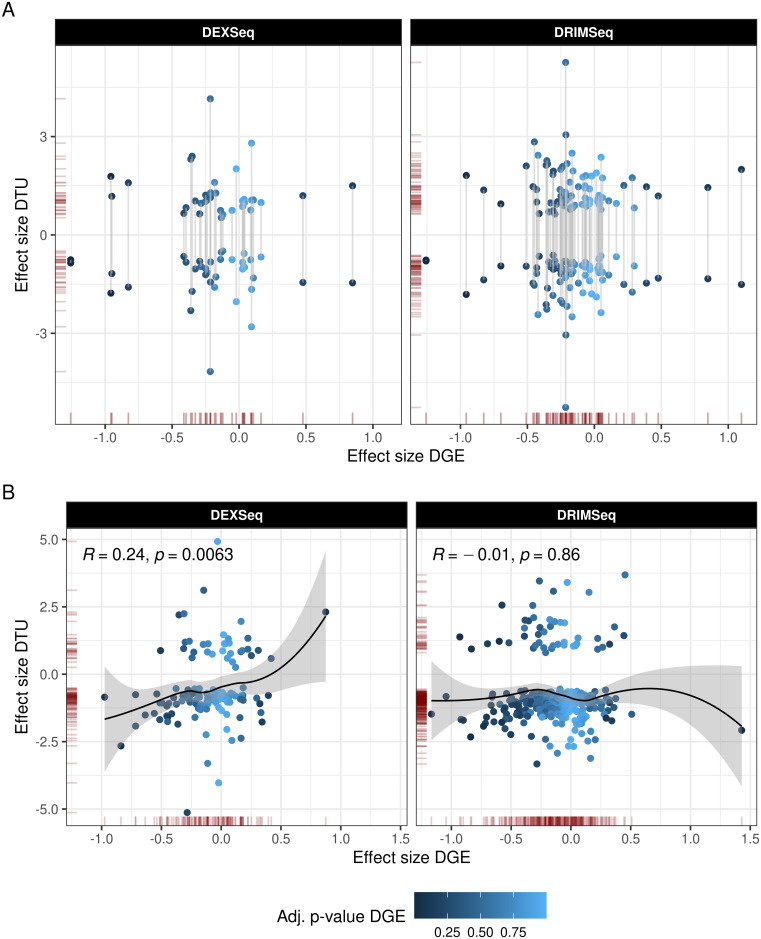
Concordance with DGE.The plot shows the relationship between the DTU effect size for each transcript (y-axis) and DGE effect size (x-axis). Data points correspond to transcripts. The x-coordinate of each point represents the effect size estimated for its parent gene in DGE analysis. The color scale indicates DGE significance after correction. A: DTU genes with 2 DTU events, with connected points representing each of the events from the gene. B: DTU genes with a single DTU event.